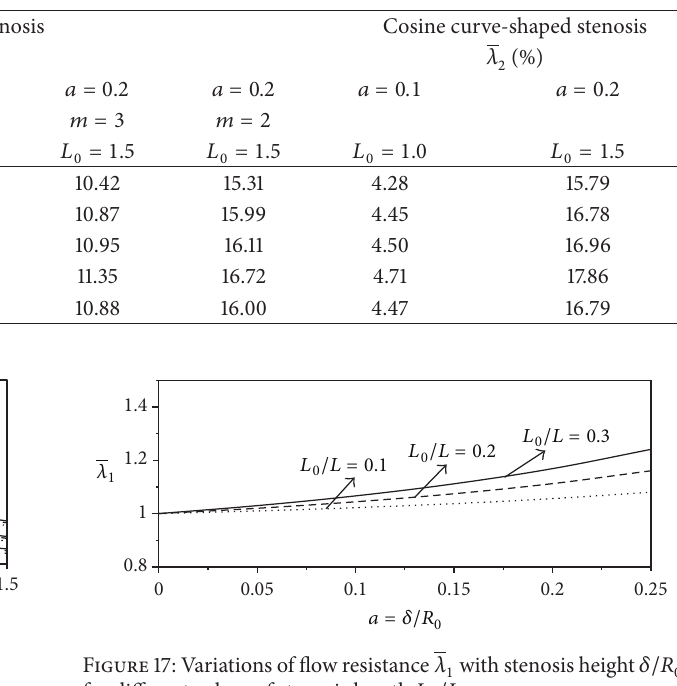
Table 4: Estimates of percentage of increase in resistance to flow 𝜆 2 for arteries with different radii and with (i) bell-shaped stenosis (ii) cosine curve-shaped stenosis.